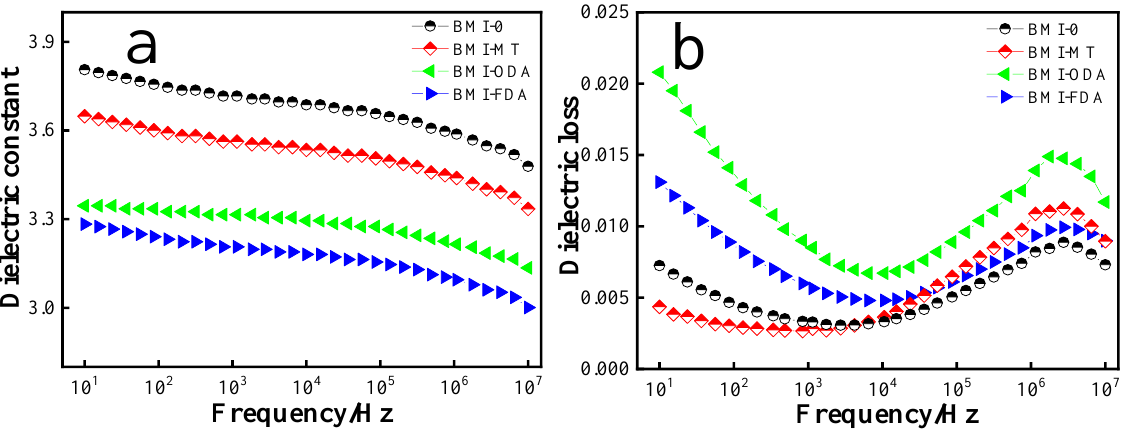
Figure 8. Dielectric property curves of BMI-NH 2 . ( a ) Dielectric property and ( b ) dielectric loss.